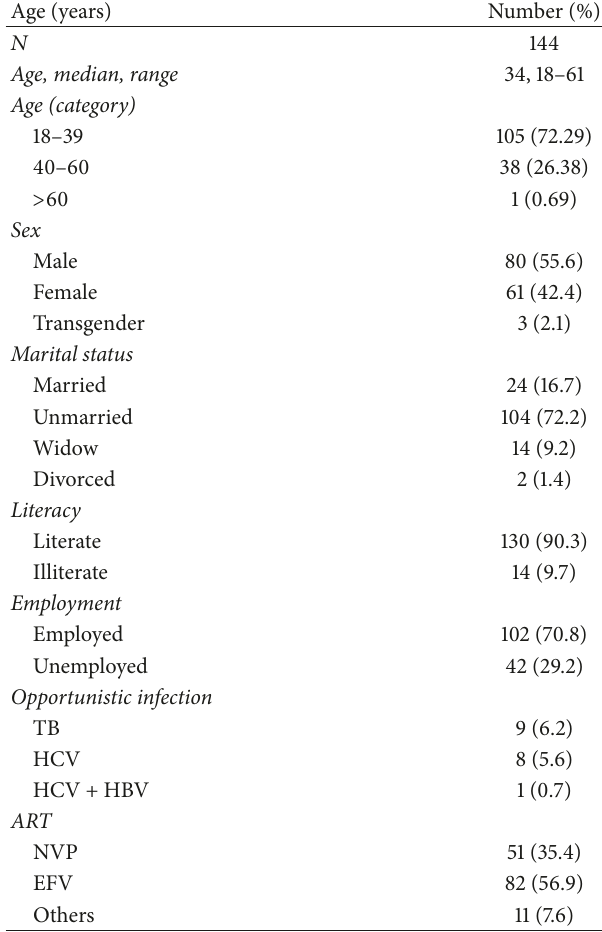
Table 1: Demographics and patient